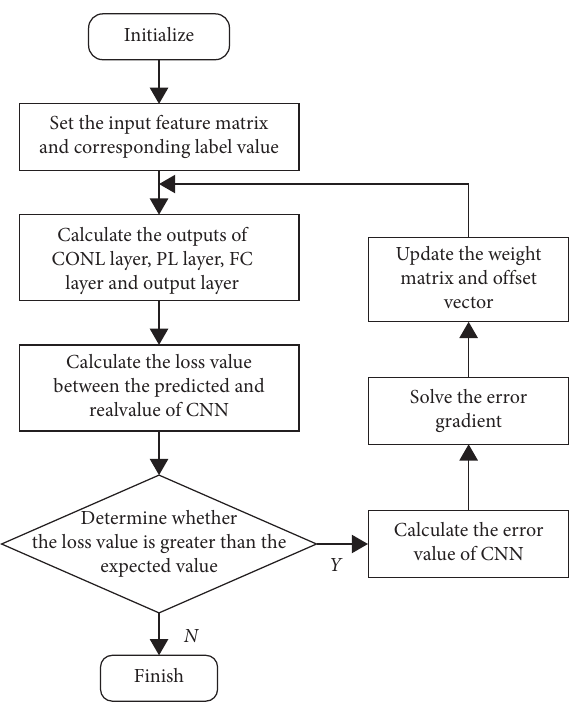
Figure 1: CNN training process flow